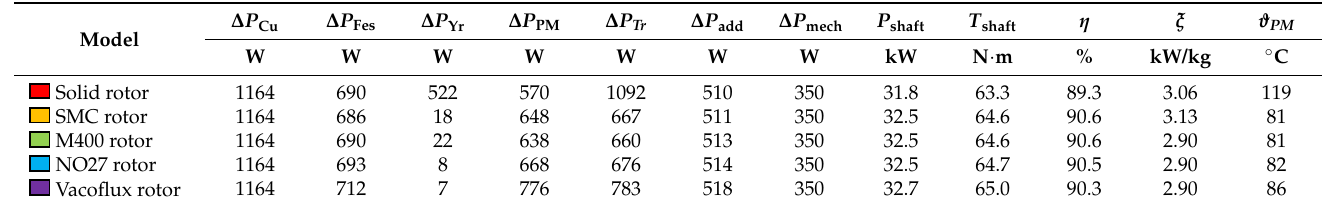
Figure 3. Distribution of the flux density from permanent magnets in the elements of the electro- magnetic circuit of the motor model. Table 2. Basic properties of the analyzed materials in the rotor yoke. Table 3. FEM analysis results for the rated rotational speed n = 4800 rpm ( f = 800 Hz) and the current density in the winding J = 15 A/mm 2 .